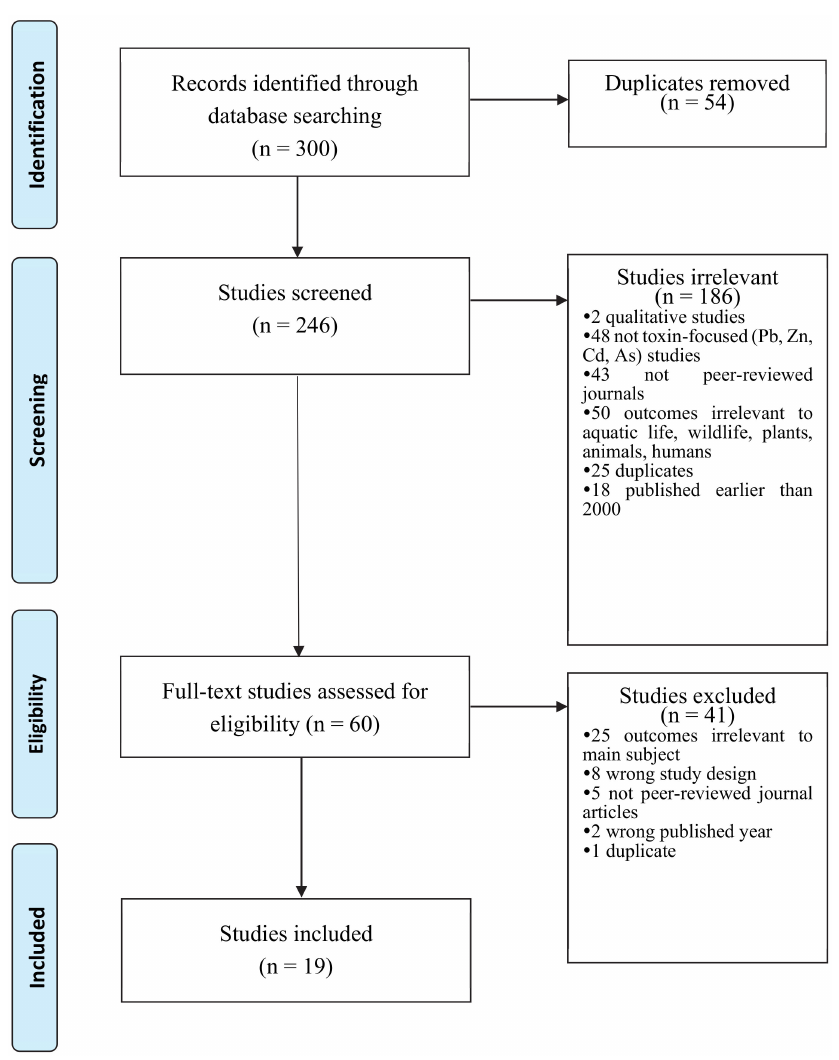
Figure 6. PRISMA Flowchart of Study Selection